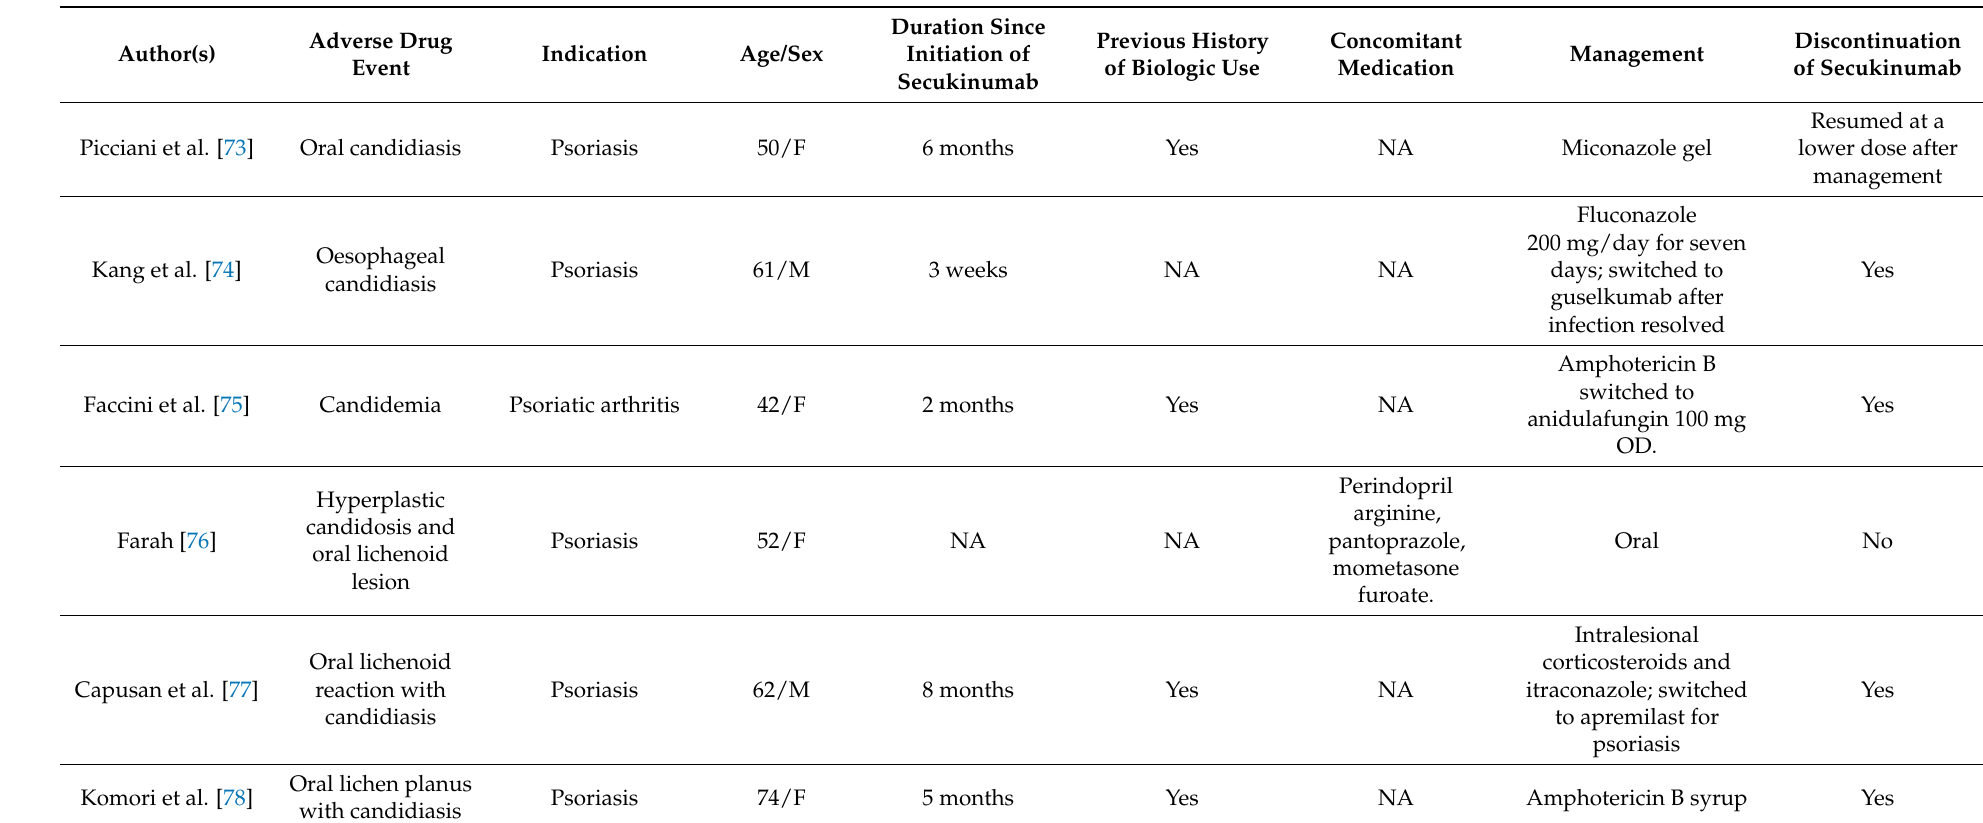
Table 3. Case reports of candidiasis associated with secukinumab